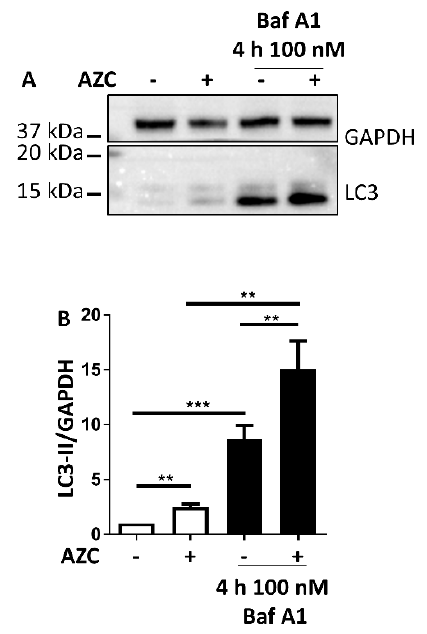
Figure 3. AZC induces autophagy. Cells were treated for 6 h with 5 mM AZC, and during the last 4 h 100 nM bafilomycin A1 (Baf A1) was added to inhibit autolysosomal degradation. ( A ) A representative blot of twelve independent experiments each performed in duplicate showing LC3-II protein levels. Glyceraldehyde 3-phosphate dehydrogenase (GAPDH) was used as loading control. ( B ) Quantification of LC3-II levels in ( A ) shown as mean ± SEM relative to untreated control. ** p < 0.01, *** p < 0.001.